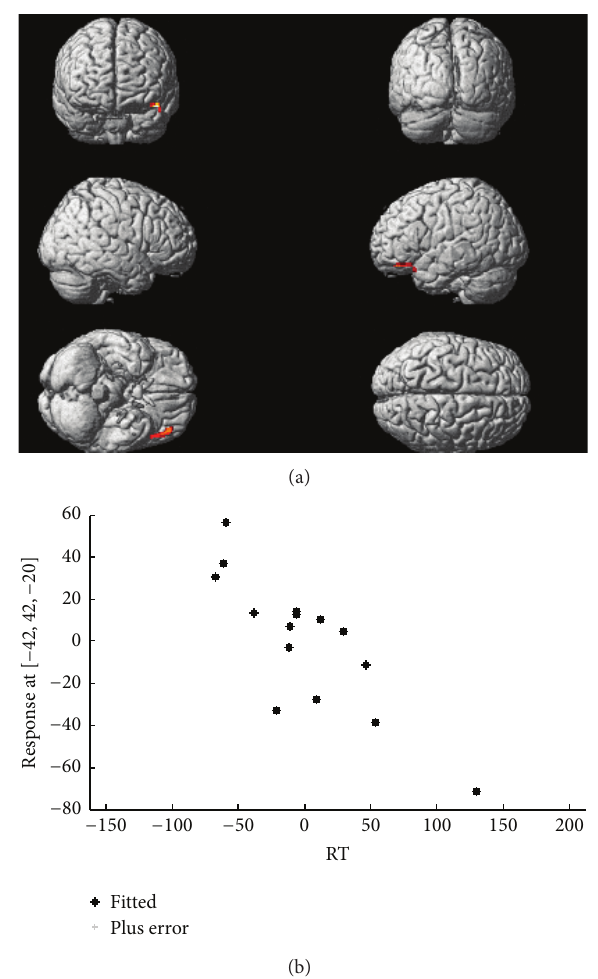
Figure 2: Correlation between 18 F-DOPA uptake and reaction time. The upper panel shows whole brain voxel-wise correlation analysis depicting (superimposed to a brain rendering) the sites of significant inverse correlation between reaction time and PET- assessed dopaminergic activity. The cluster includes areas pertaining to the middle and inferior frontal as well as the superior temporal gyri in the left hemisphere. The lower panel shows the plot as automatically generated by SPM expressing the correlation between the two variables after transformation of the native values around